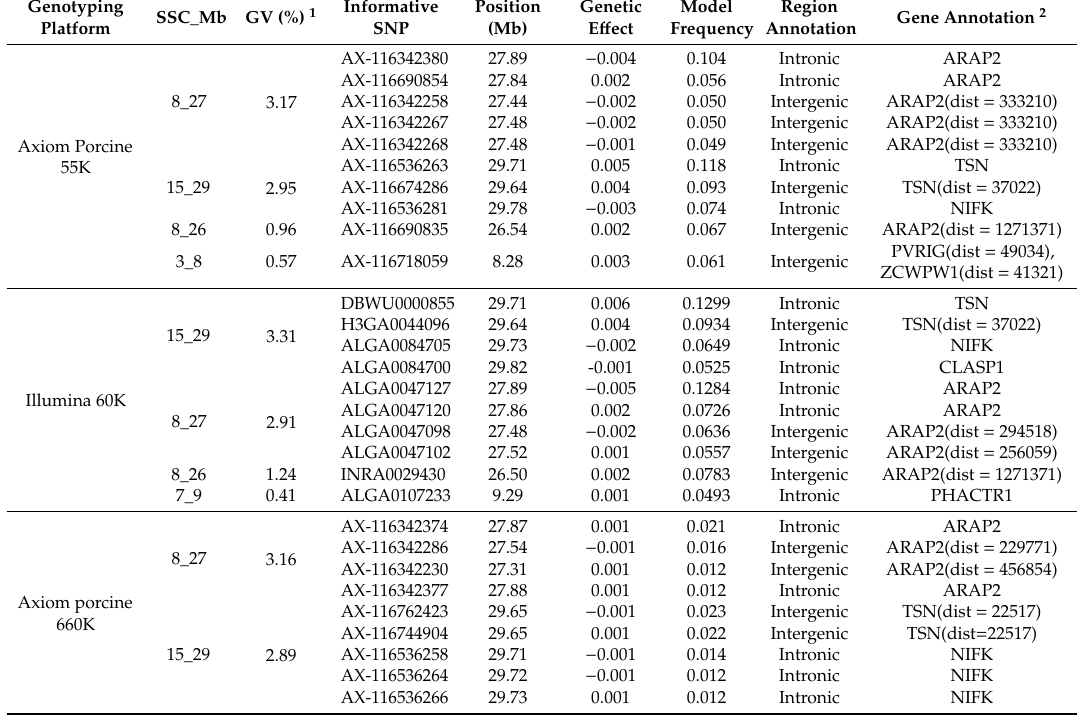
Table 3. Summary of GWAS in each genotyping platform with the significant 1 Mb windows that were associated with the individual birth weight (IBW) trait in Korean Yorkshire